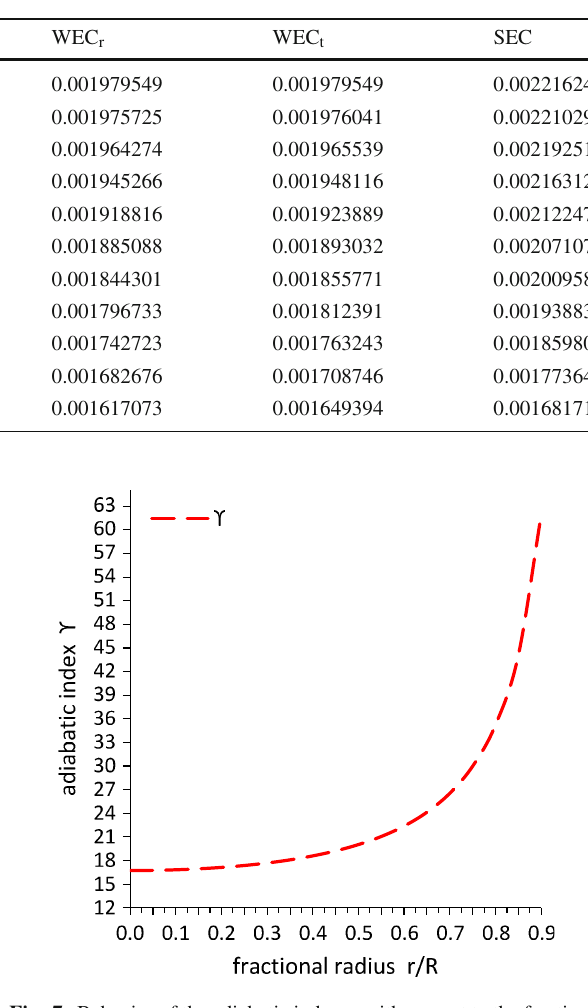
Fig. 7 Behavior of the adiabatic index γ with respect to the fractional radial distance ( r / R ) for RX J 1856-37. For plotting this figure we have employed the same data set of numerical values as used in Figs. 1, 2, 3, 4, 5 and